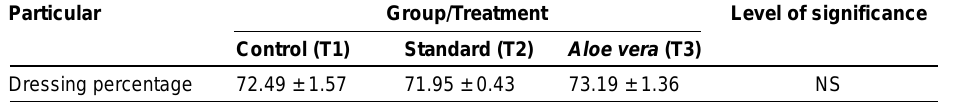
Table-1. Effects of supplementation of Aloe vera on the Dressing Percentage of broiler chicks